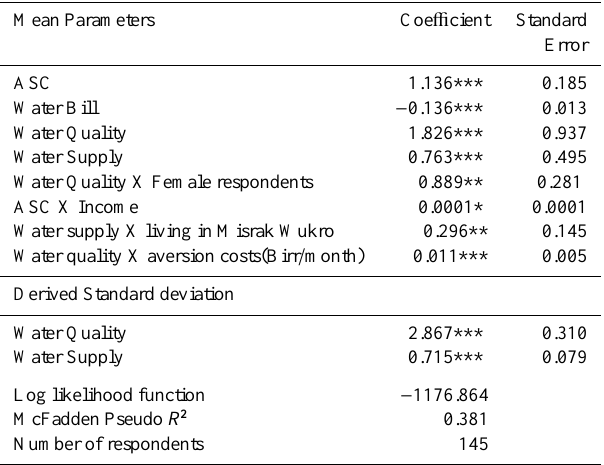
Table 4. Results of random parameter logit model with interactions.